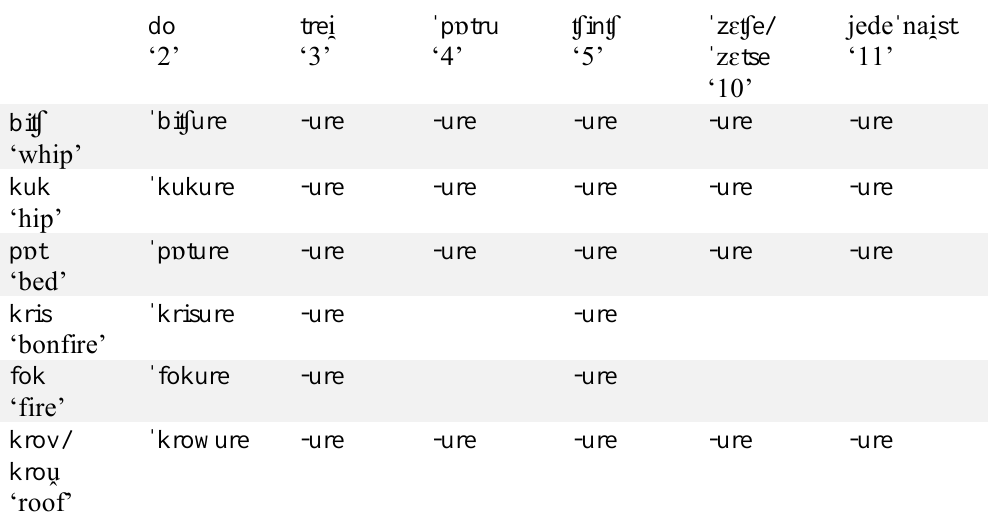
Table 9. Unitary behaviour of some genus alternans nouns taking -ure